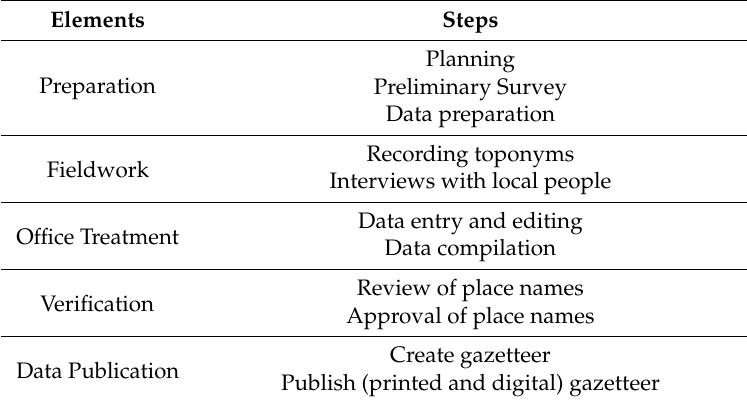
Table 3. The elements and steps of toponymic survey